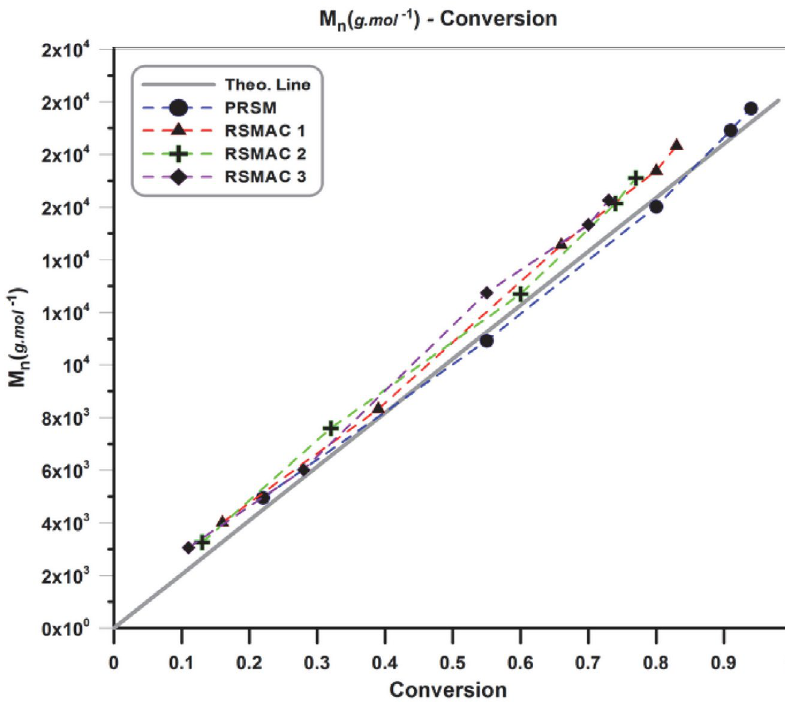
Figure 6. Variation of molecular weight versus conversion for the PRSM and RSMAC 1-3